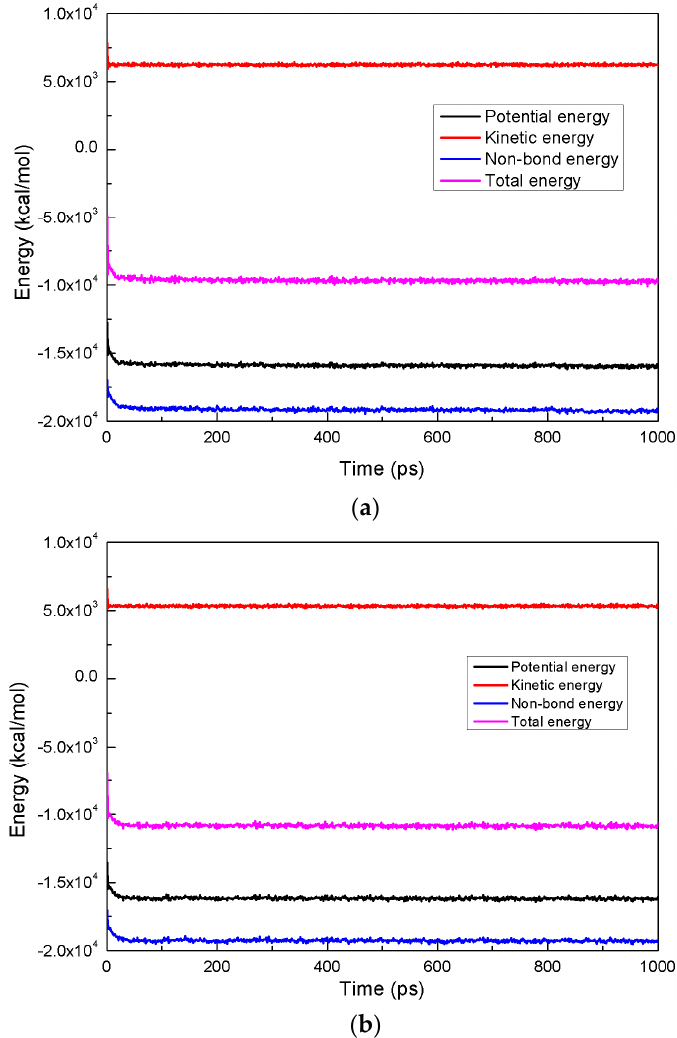
Figure 9. The fluctuation curves of energy during energy minimization. ( a ) Coal-water- NPEO 10 system; and ( b ) coal-water system.